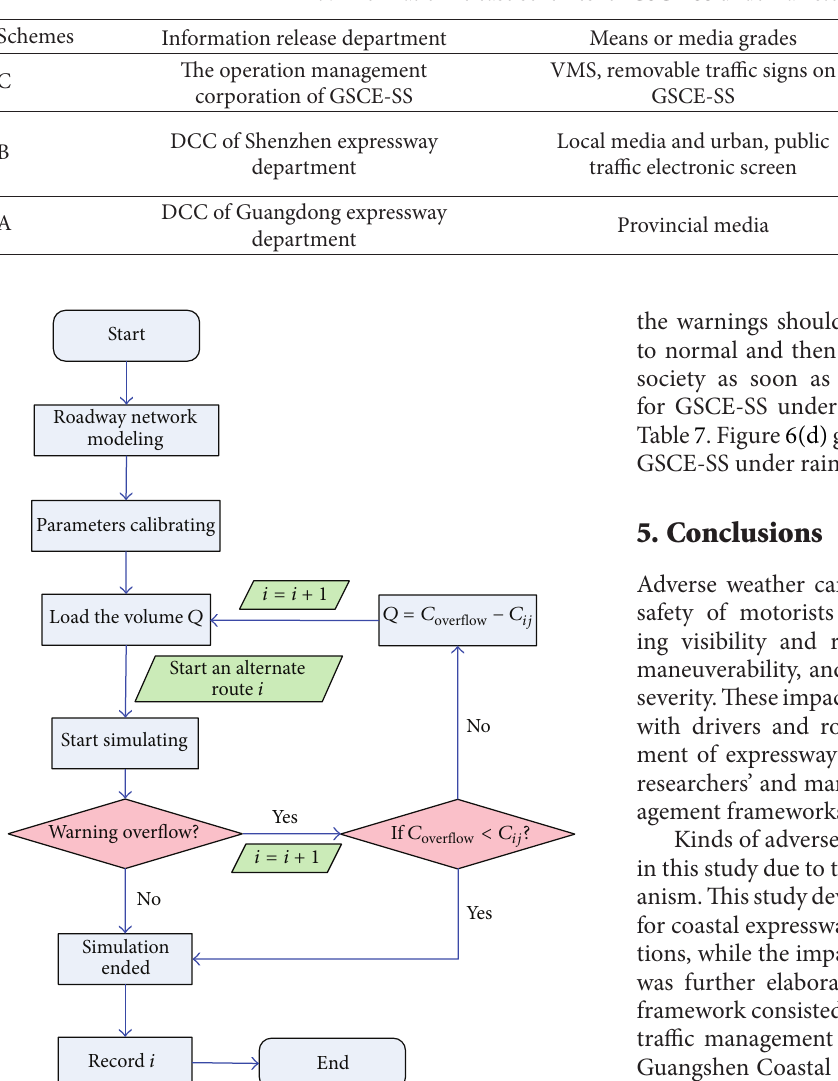
Table 7: Information release schemes for GSCE-SS under rainstorm conditions.